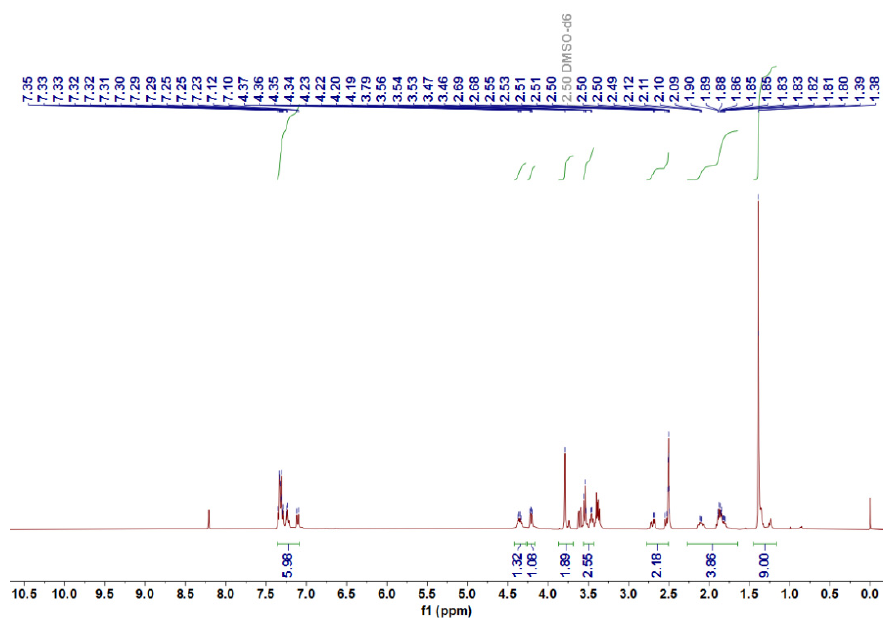
Figure 3. NMR analysis of Boc-Cys(Bzl)-Pro-COOH synthesized on BSA/NHS strategy.